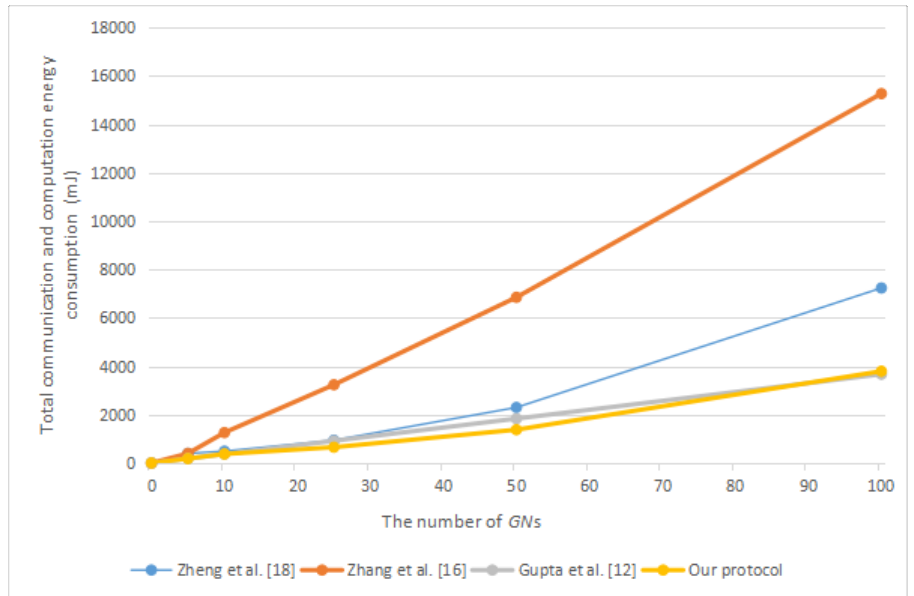
Figure 9. The communication energy consumption of each group member in different protocols.